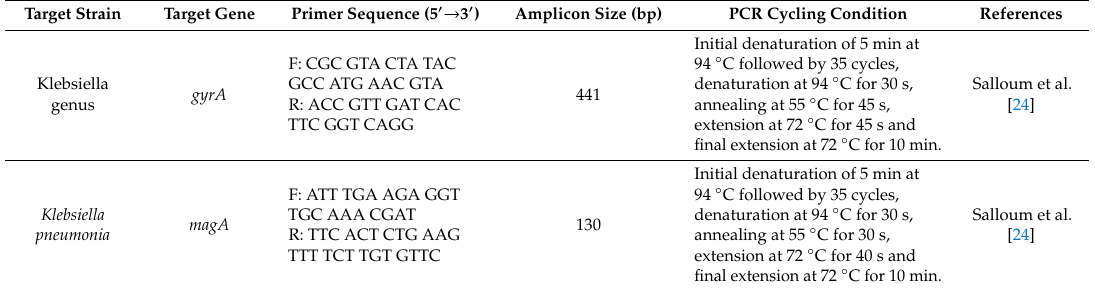
Table 1. PrimersequencesoftargetspeciesandtheirrespectiveampliconsizesandPCRcyclingconditions. Target Strain Target Gene Primer Sequence (5 (cid:48) → 3 (cid:48) ) Amplicon Size